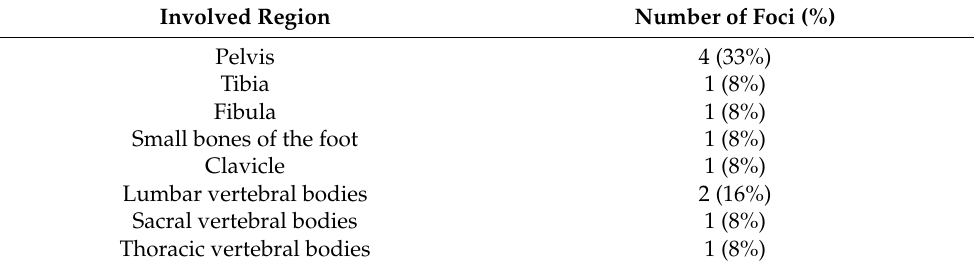
Table 2. Localization of bone lesions in the study patients.